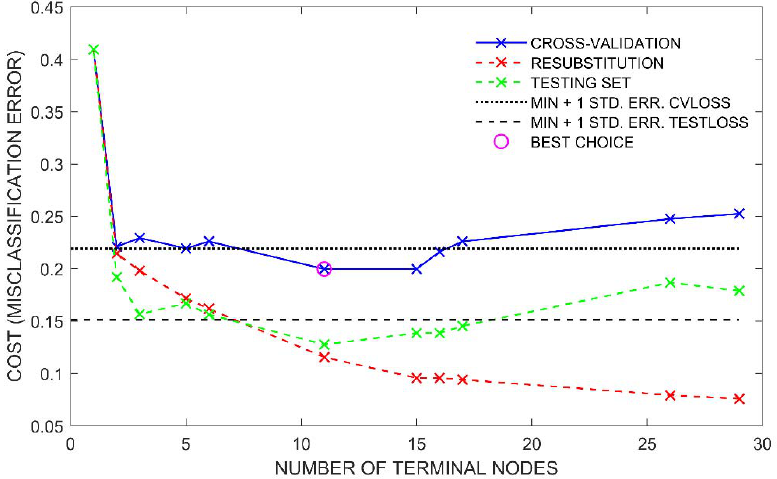
Figure 6. Errors of subtrees of classification tree model with custom misclassification cost matrix ( c = 2).